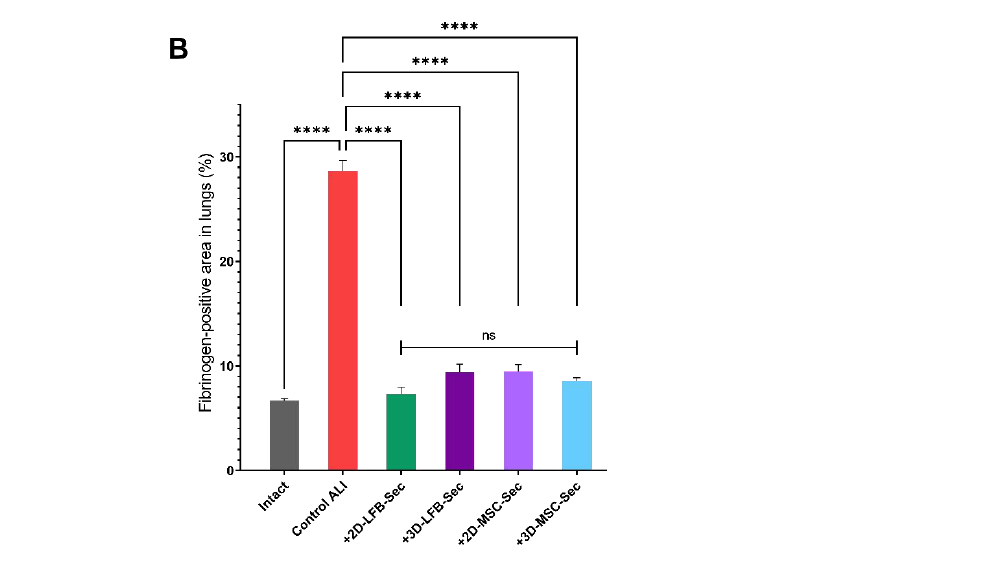
Figure 7. Immunohistochemistry and fibrinogen-positive area in lungs. ( A ) Lung tissue sections in the control, nontreated, and acute lung injury (ALI) groups after 2D-LFB-Sec, 3D-LFB-Sec, 2D-MSC- Sec, and 3D-MSC-Sec inhalation. Sections were stained with antibodies against fibrinogen, and cell nuclei were labeled with hematoxylin; ×20 magnification; scale bars = 100 μm. ( B ) The percentage of fibrinogen-positive areas in the total area of lung tissue in the control, nontreated, and ALI groups after 2D-LFB-Sec, 3D-LFB-Sec, 2D-MSC-Sec, and 3D-MSC-Sec inhalation. Data are presented as the mean ± SEM ( n = 54). ****, adjusted p < 0.0001 for Intact vs. Control ALI, 2D-LFB-Sec vs. Control ALI, 3D-LFB-Sec vs. Control ALI, 2D-MSC-Sec vs. Control ALI, and 3D-MSC-Sec vs. Control ALI. (ns) represents a nonsignificant difference for multiple comparisons between 2D-LFB-Sec, 3D-LFB-Sec, 2D-MSC-Sec, and 3D-MSC-sec. Analyses were performed using Brown – Forsythe and Welch analy- sis of variance (ANOVA) with the Games – Howell post hoc test. ALI, acute lung injury; MSC, mes- enchymal stromal cell; LFB, lung fibroblast.